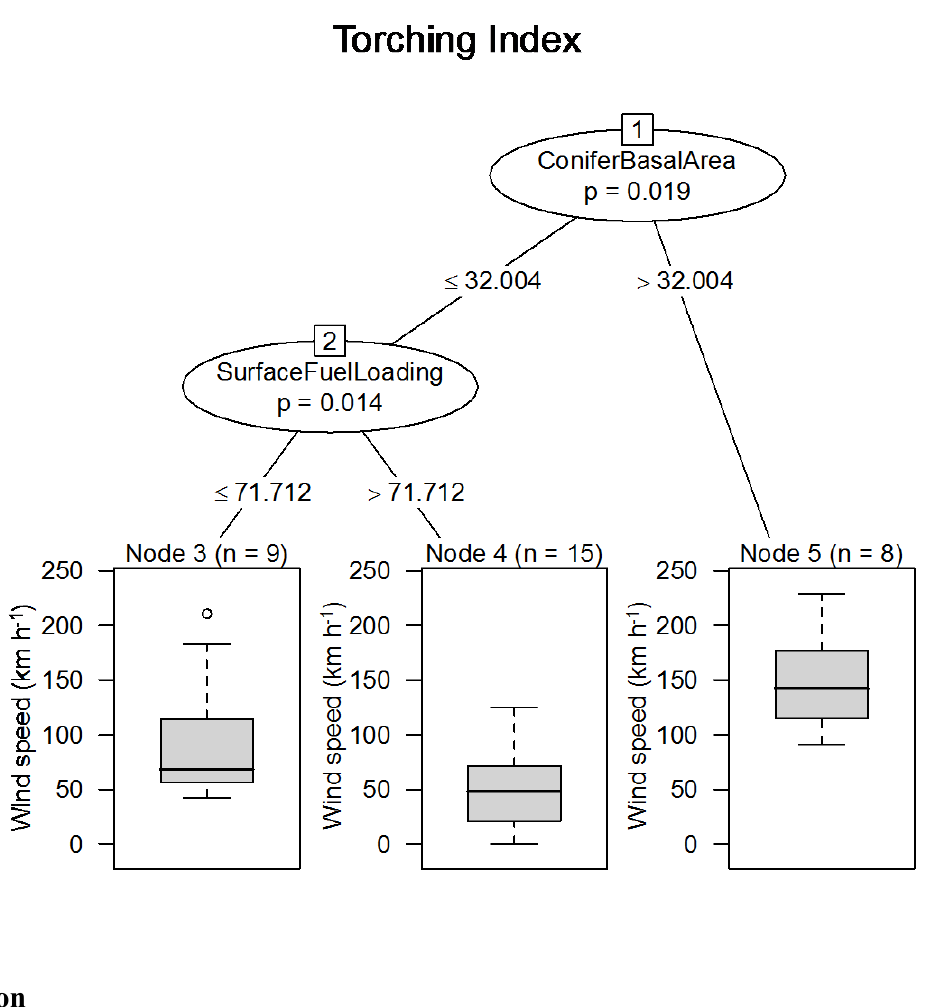
Figure 5. Classification tree results suggested two significantly different groups that influence torching index: conifer basal area and surface fuel